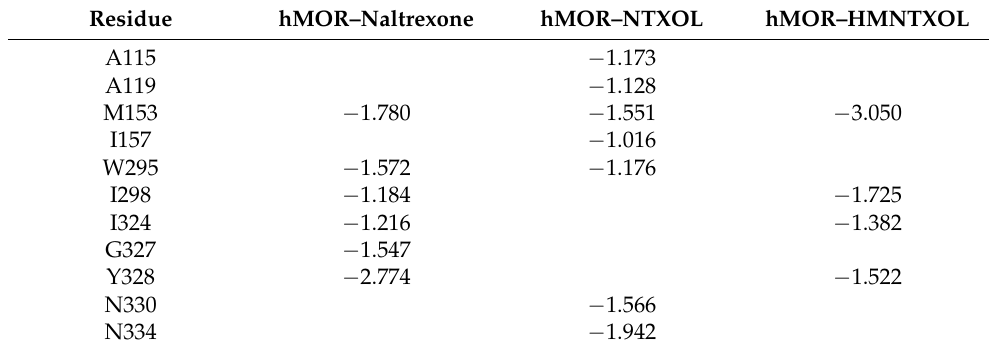
Table 2. Per-residue free energy for hMOR–ligand interaction complexes (values in